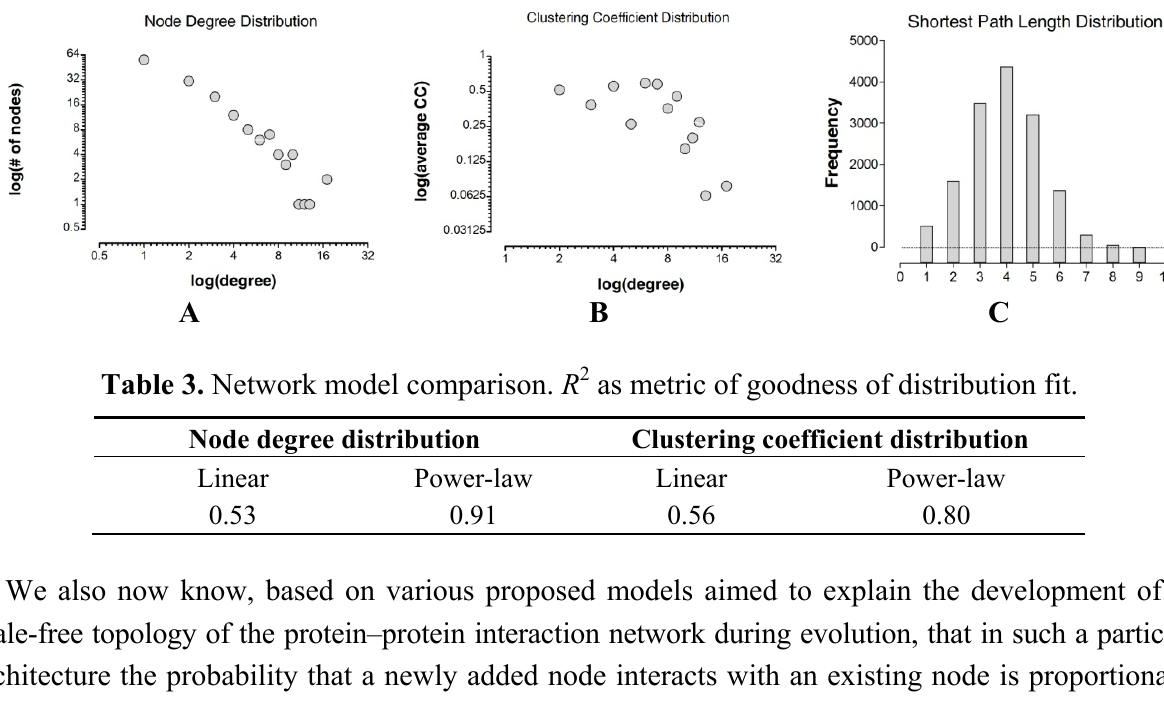
Figure 2. Topological properties distributions. In ( A ) and ( B ) we present the node degree distribution and clustering coefficient distribution for the GPCR receptor–receptor interaction network, respectively. The network shows power-law node degree and clustering coefficient distributions (see Table 3 for further details). Axes are plotted on logarithmic scale. In ( C ) we show the path length distribution of the GPCR-HetNet.